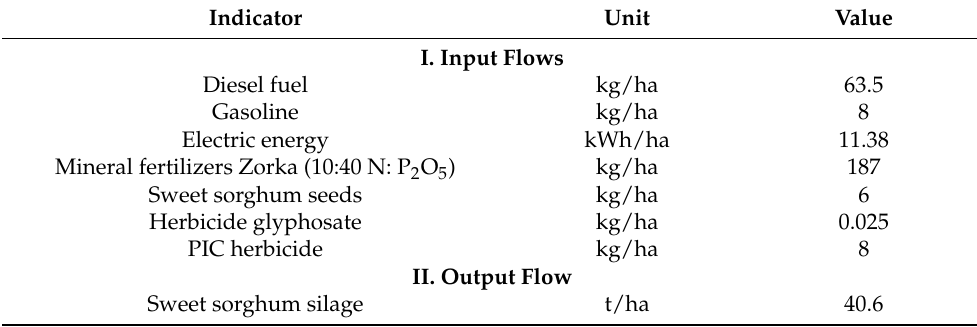
Table 7. Input and output material and energy flows.